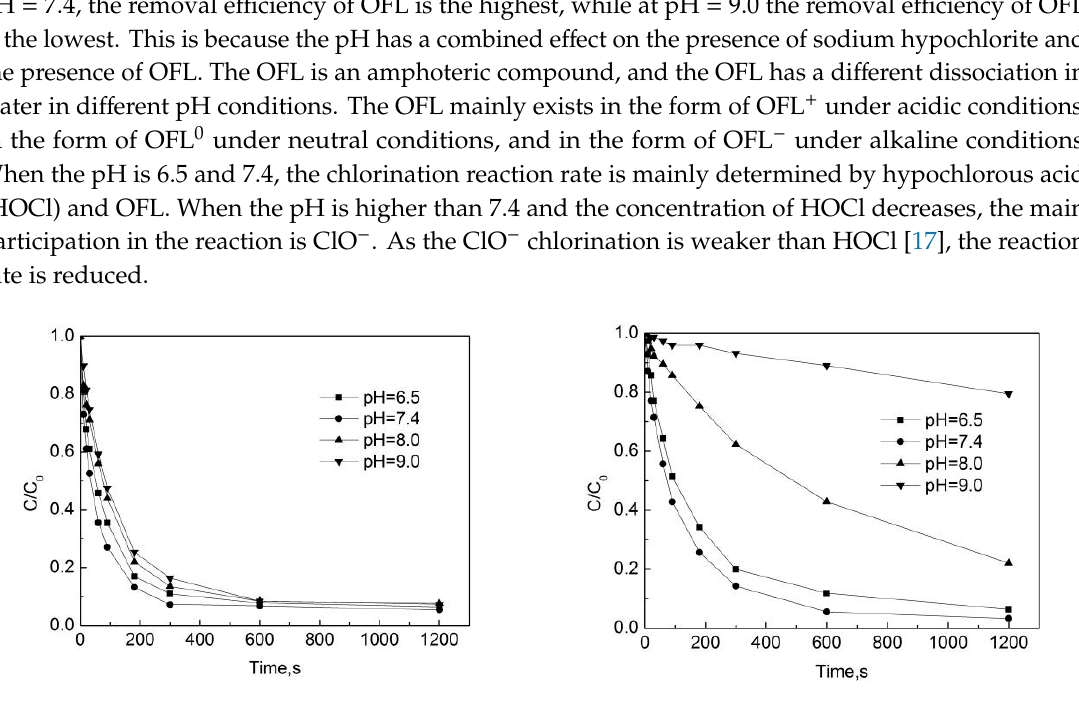
Figure 4. The relation curve between the effective free chlorine concentration and k obs .